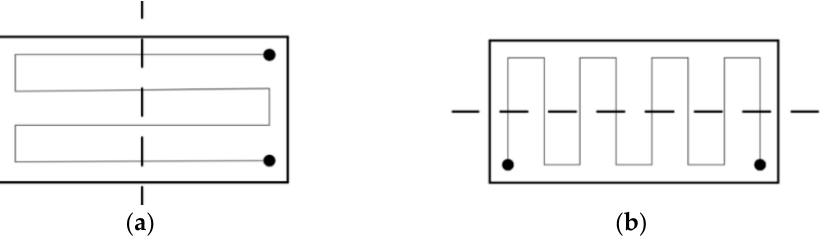
Figure 8. Different search direction of UAV. ( a ) Vertical search direction; ( b ) horizontal search direction.